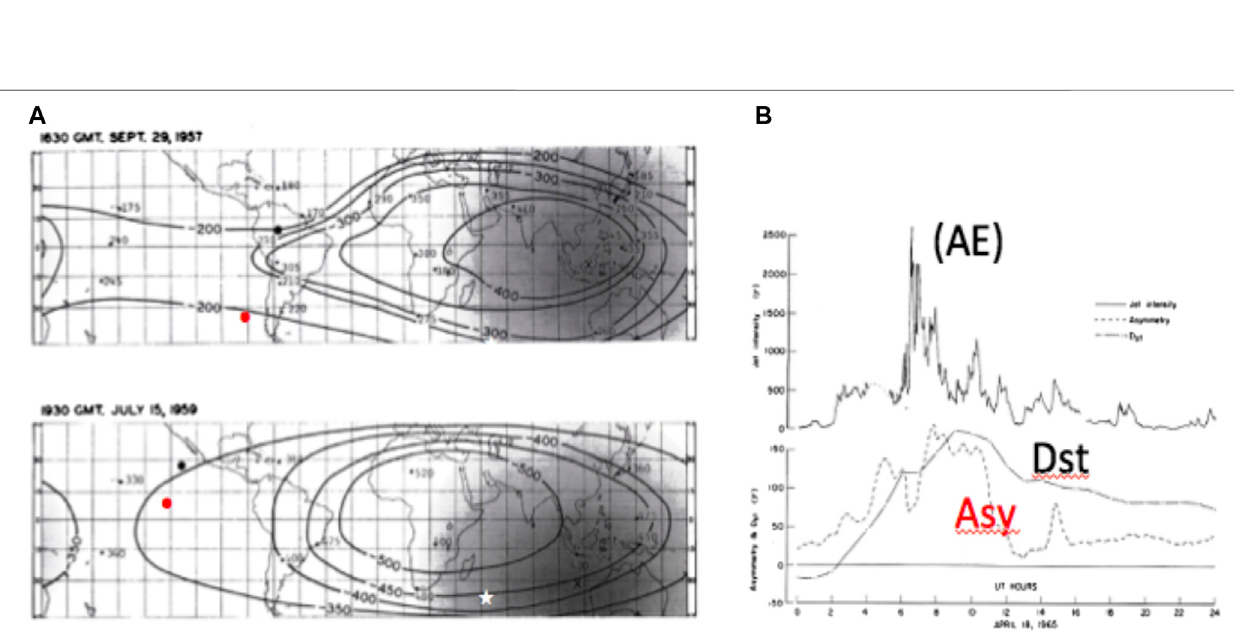
FIGURE 6 | (A) Two examples of the asymmetric development of the main phase. The subsolar point is shown by a red dot (B) The relationship between the Dst, the asymmetry index (Asy) and the jet intensity (similar to the AE index before the AE index became available) (Akasofu and Chapman, 1964).